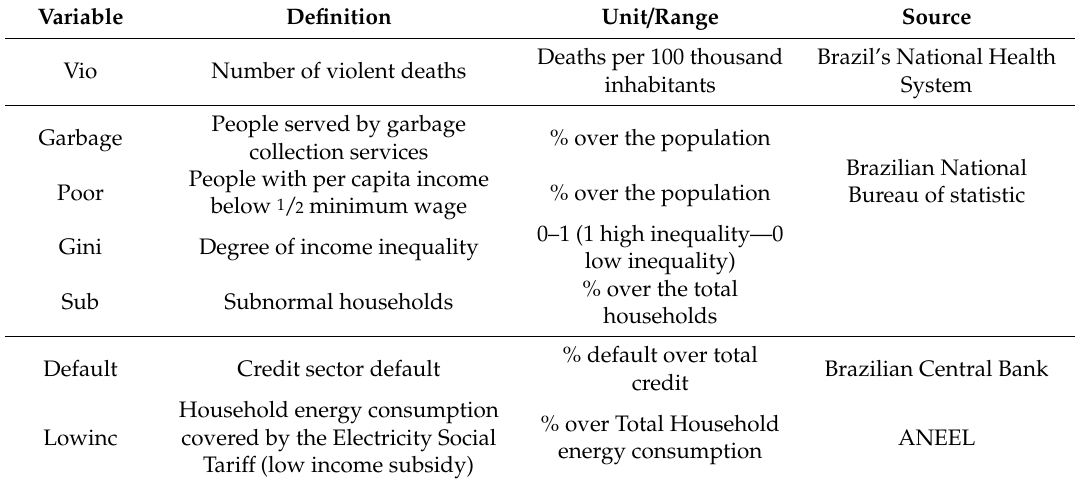
Table 1. The explanatory variables used in the application of stochastic frontier analysis (SFA) and the panel data econometric model specified by the National Electric Energy Agency (ANEEL) [10].